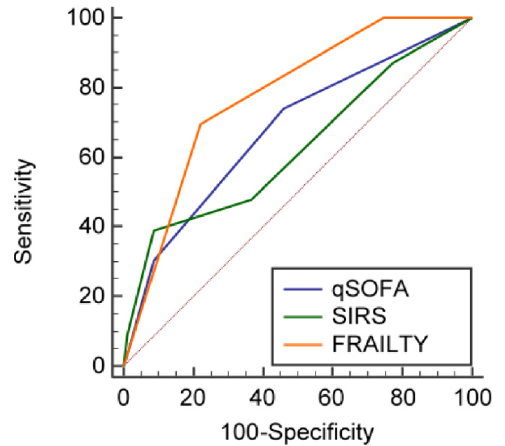
Figure 1. Receiver Operating Characteristic (ROC) curves showing the predictive capacity of quick Sequential Organ Failure Assessment (qSOFA), Systemic Inflammatory Response Syndrome (SIRS), and frailty (operationalized according to the Rockwood Clinical Frailty Scale, RCFS) for in-hospital mortality in the studied geriatric population. Table 2. Logistic regression analysis showing the association of qSOFA score at admission with the primary study outcome (in-hospital mortality) in elderly patients with suspected sepsis ( n = 272).